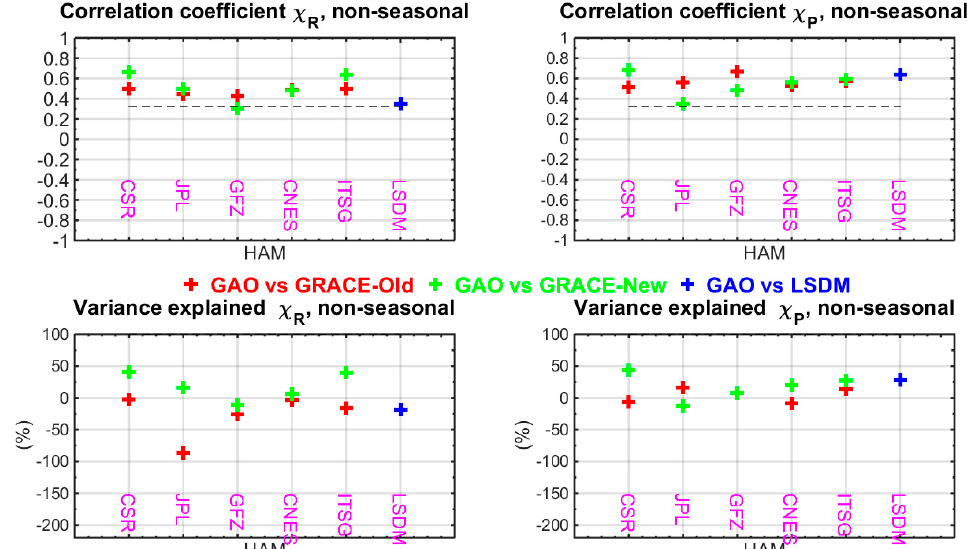
Figure 10. Correlation coe ffi cients of χ R and χ P parts of non-seasonal variation between GAO and HAM computed from GRACE solutions and the LSDM and the percentage of variance in GAO explained by HAM functions. The critical value of the correlation coe ffi cient for 25 independent points and a confidence level of 0.95 was 0.34. The standard error of the di ff erence between two correlation coe ffi cients for 25 independent points was 0.30.